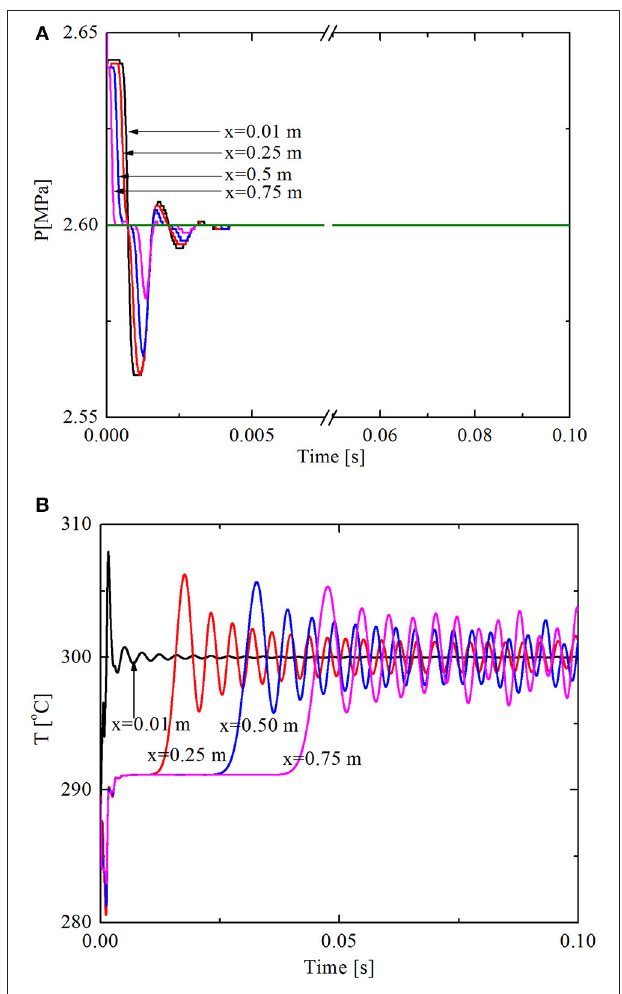
FIGURE 5 | Responses of the hypothesized opposite treatments under outlet pressure transient. (A) Pressure responses. (B) Temperature